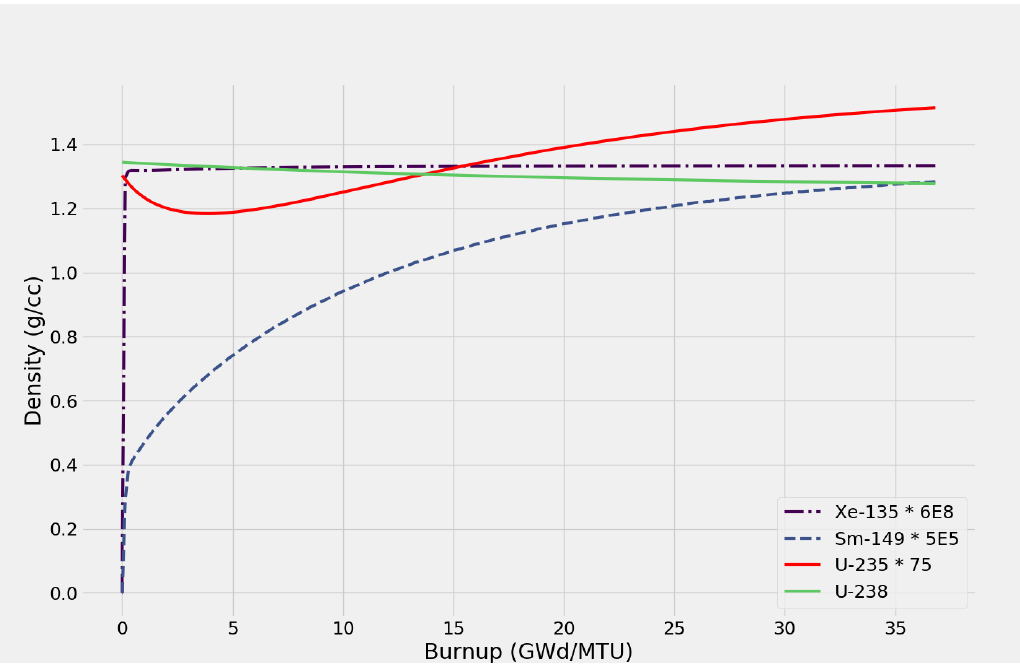
Figure 5. Mass densities of key uranium isotopes and fission product poisons as a function of burnup. Note the scaling